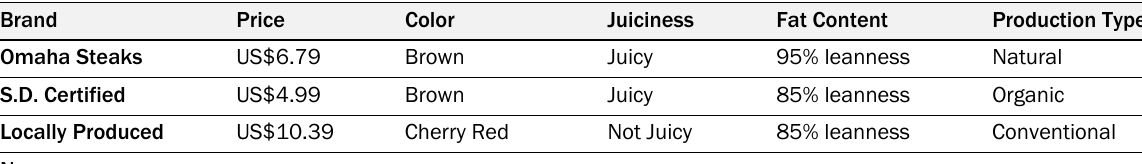
Table 2. Sample Choice Set Used in the Conjoint Experiment